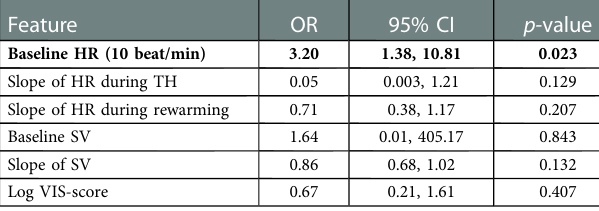
TABLE 6 Logistic regression using the features of the cardiac function